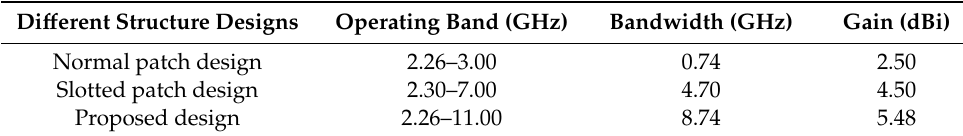
Figure 4. The effect of different design structure on: ( a ) S 11 (reflection coefficient); ( b ) Maximum gain. Figure 4. The e ff ect of di ff erent design structure on: ( a ) S 11 (reflection coe ffi cient); ( b ) Maximum gain. Table 2. Di ff erent structure designs comparison table.